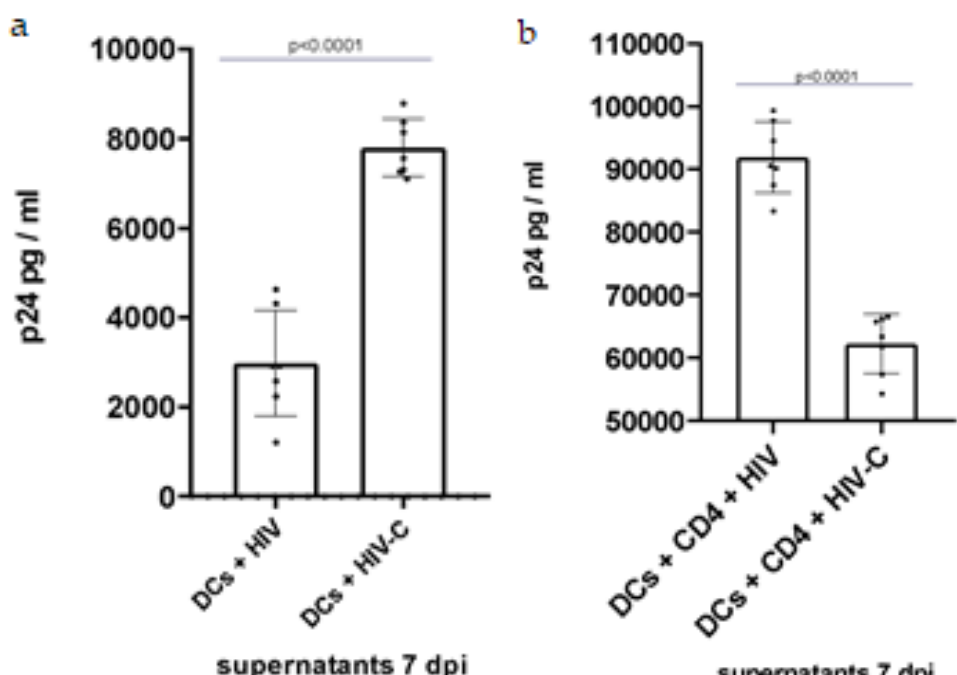
Figure 2. HIV/HIV-C infection of DCs and DC/CD4 + T-cell co-cultures. ( a ) Quantification of infection in 7 dpi supernatants from HIV/HIV-C-infected DCs. DCs incubated with HIV show significantly decreased, moderate productive infection compared to HIV-C ( p < 0.0001). Experiments were performed for a minimum of 3 independent replicates, and statistical significance was analyzed using GraphPad Prism software v9 [60] and unpaired Student’s t -test. Abbreviation: dpi: days postinfection. ( b ) Quantification of infection in 7 dpi supernatants from HIV/HIV-C-infected DC/CD4 + T-cell co-culture. Infection with HIV-C is decreased and moderate compared to the control infection with HIV ( p < 0.0001). Experiments were performed for a minimum of 3 independent replicates, and sta- tistical significance was analyzed using GraphPad Prism software v9 [60] and unpaired Student’s t - test.